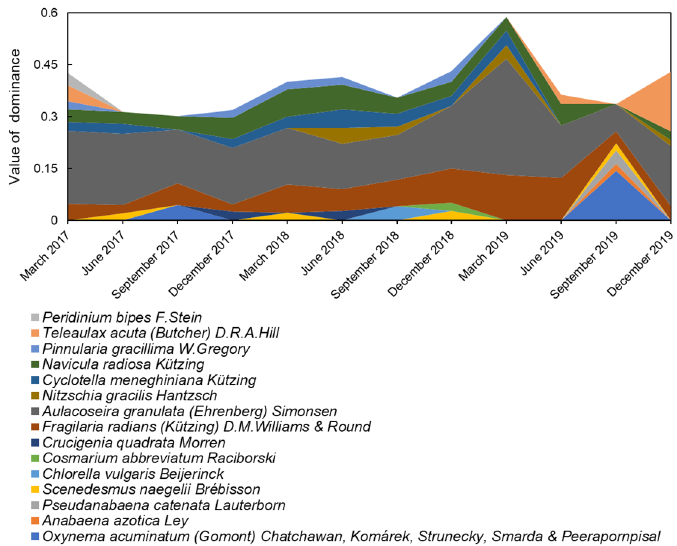
Figure 4. Dominant species of phytoplankton and their interannual variation in Dongting Lake.